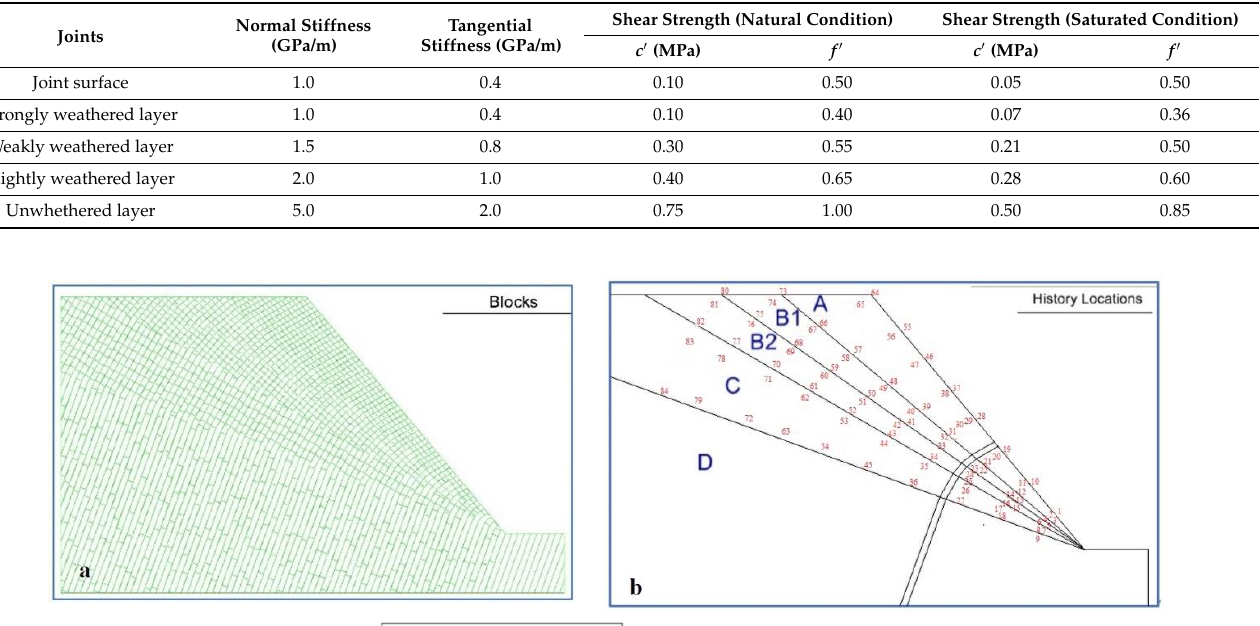
Table 2. The mechanical parameters of joints.